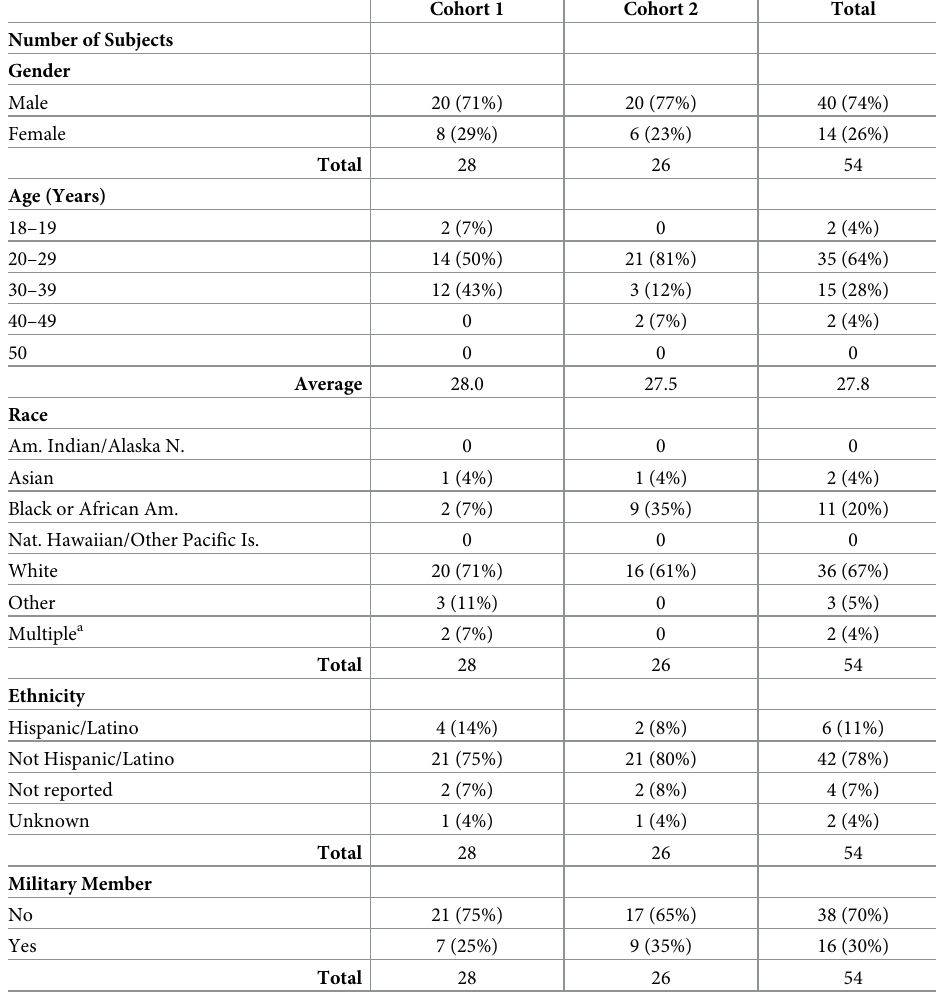
Table 1. Demographic composition of Cohort 1 and Cohort